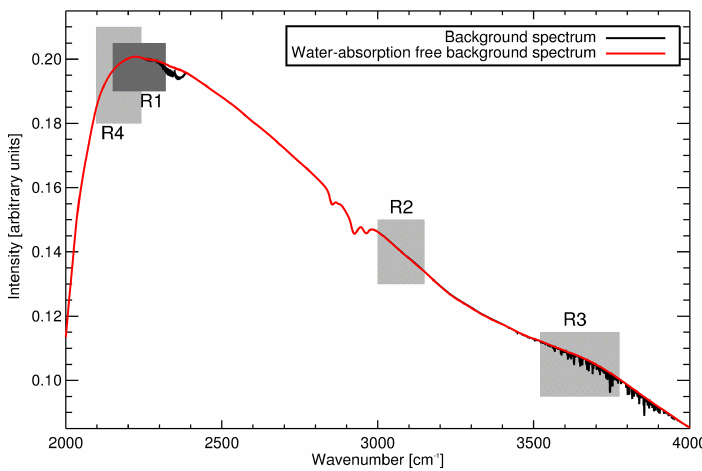
Figure B1. A typical background spectrum (black line) taken on 8 August 2014 (cell pressure of 1.6hPa) and corresponding background spectrum (red line) with water absorption spectral features removed. MALT spectral fit regions are shaded in grey.